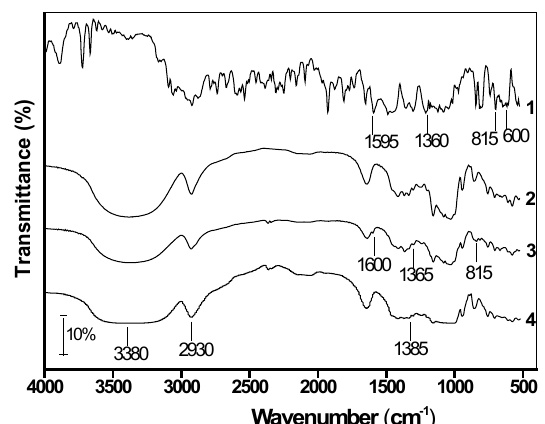
Figure 1. IR spectra of 4-toluenesulfonyl chloride (1), b -cyclodextrin before (2) and after (3) interaction with 4-toluenesulfo-